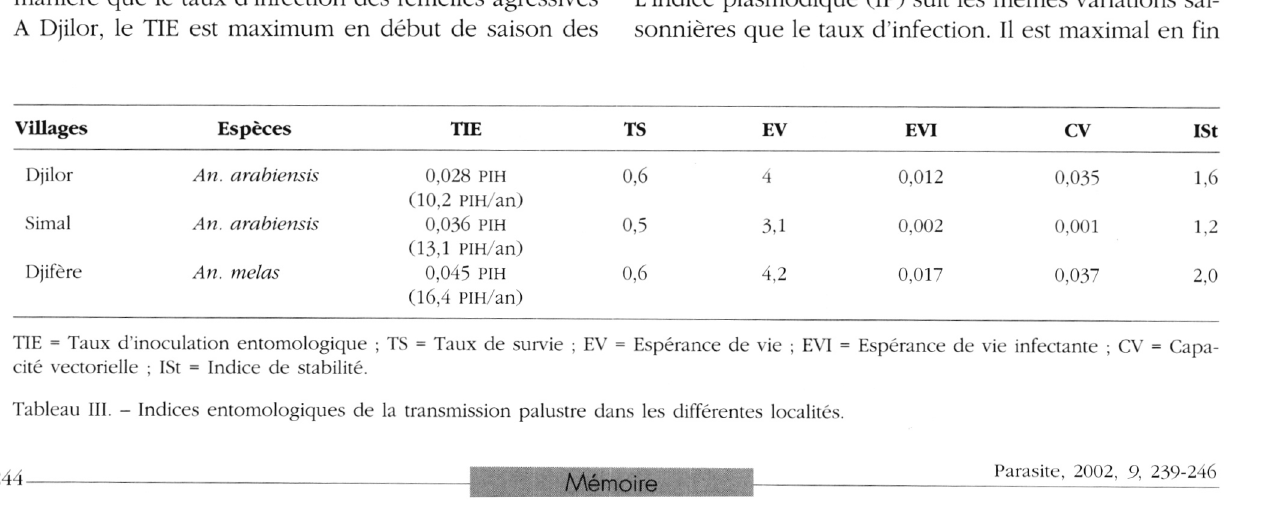
244 Mémoire Parasite, 2002, 9,